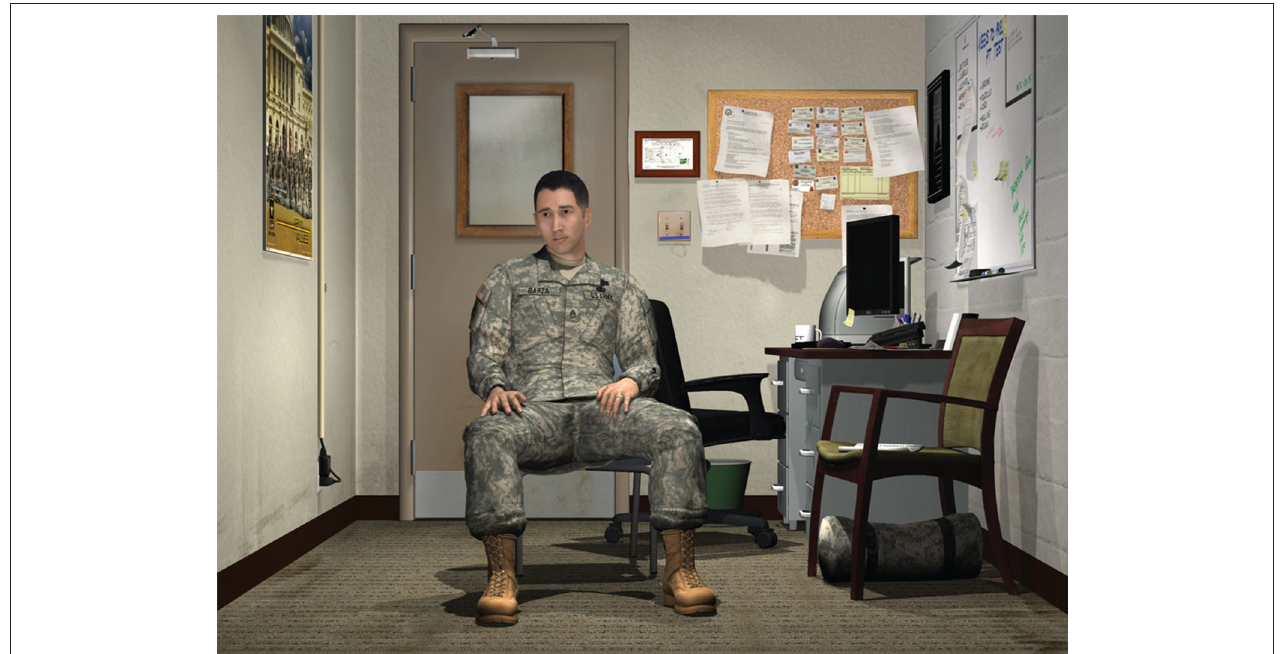
FIGURE 1 | The Emergent Leader Immersive Training Environment (ELITE) is an example of a system that helps develop junior officer communication skills; image reproduced with permission from USC ICT